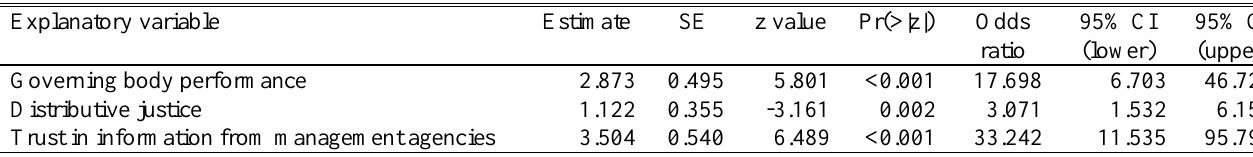
Table A1.2. Cumulative link model estimates of resource users’ (n=307) perceived legitimacy and retained explanatory variables. Log likelihood: - 571.44, condition number of Hessian: 180 Explanatory variable Governing body performance Trust in information from management